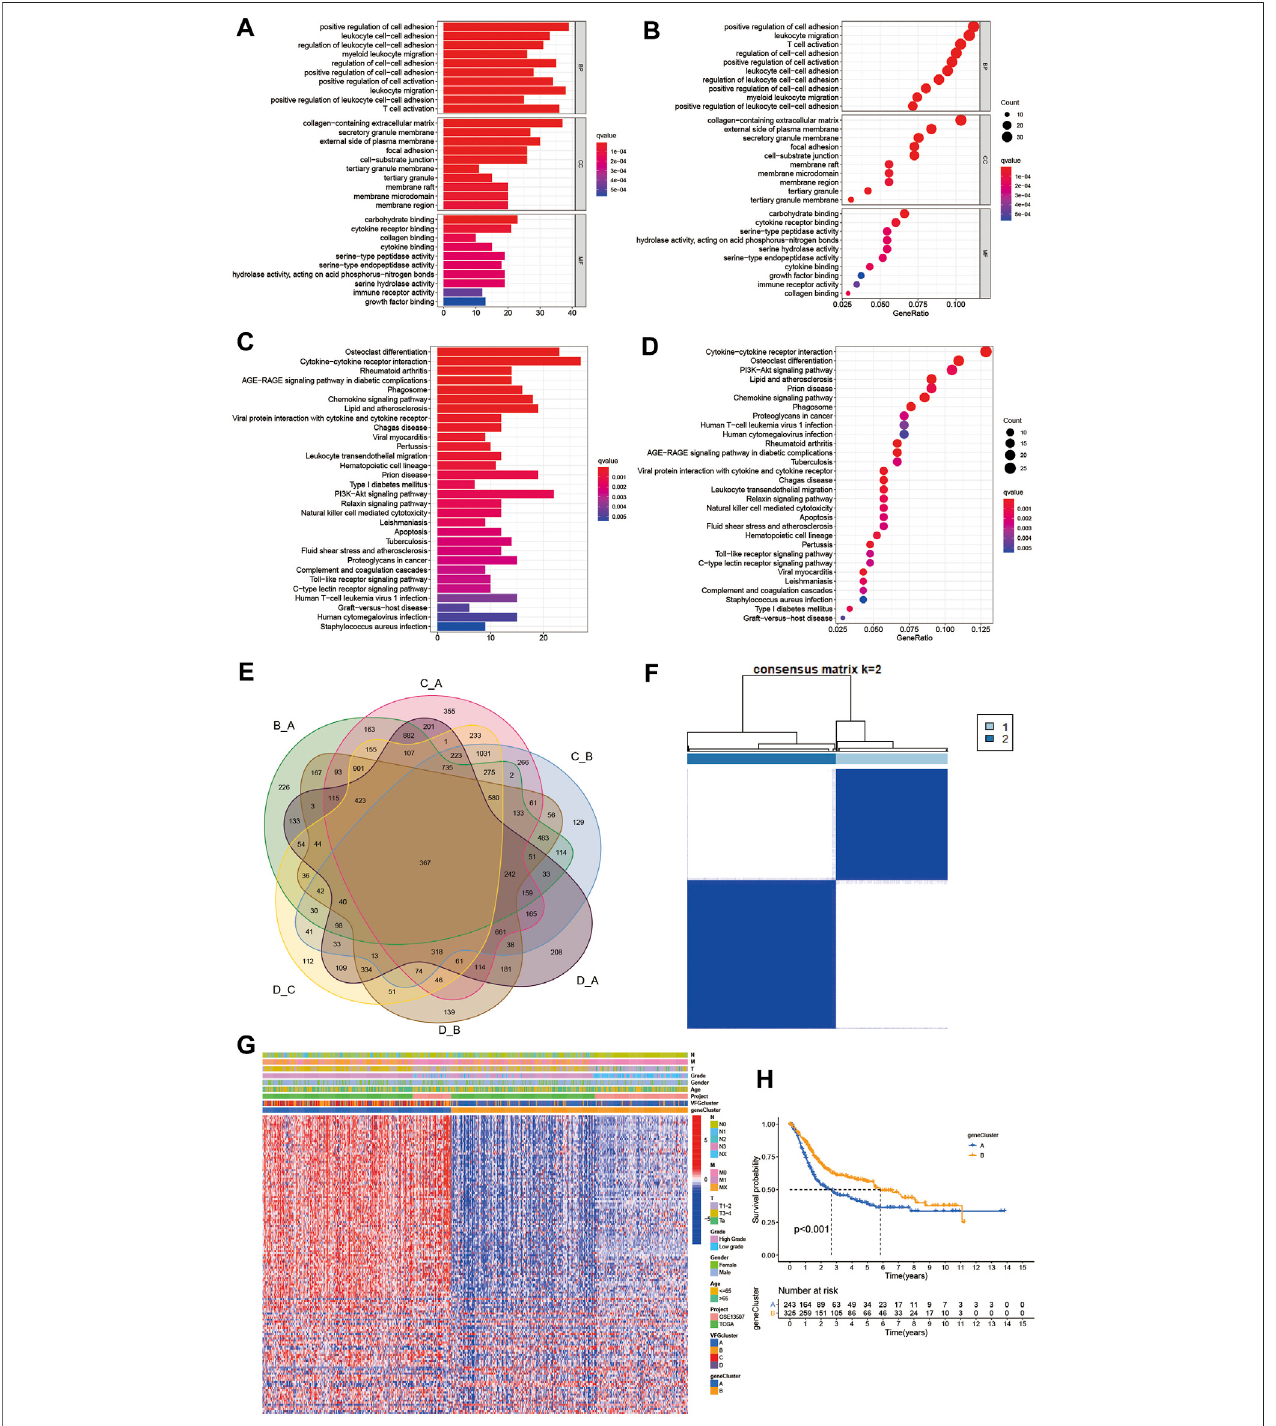
FIGURE 4 | Generation of ferroptosis gene signatures and functional annotation. (A,B) Functional annotation for VFG cluster-related DEGs using GO enrichment analysis. The color depth of the barplots and plots represented the number of genes enriched. The pathways were grouped by cellular component (CC), molecular function (MF) and biological process (BP). (C,D) Functional annotation for VFG cluster-related DEGs using KEGG enrichment analysis. The color depth of the barplots and plots represented the number of genes enriched. (E) 367 VFG cluster-related DEGs shown in the Venn diagram. (F) Unsupervised clustering of 367 VFG cluster-related DEGs in meta-cohort and consensus matrices for k = 2. (G) Unsupervised clustering of overlapping 367 VFG cluster-related DEGs in meta-cohort to classify patients into different genomic subtypes, termed as gene cluster A-B, respectively. The gene clusters, VFGclusters, project, age, gender, grade, and TNM categorywereused as patient annotations. (H) Kaplan – Meier curvesindicated ferroptosis genomic phenotypes were markedly related tooverallsurvivalof568 patients in meta-cohort, of which 243 cases were in gene cluster A and 325 cases in gene cluster B ( p < 0.001, Log-rank test).